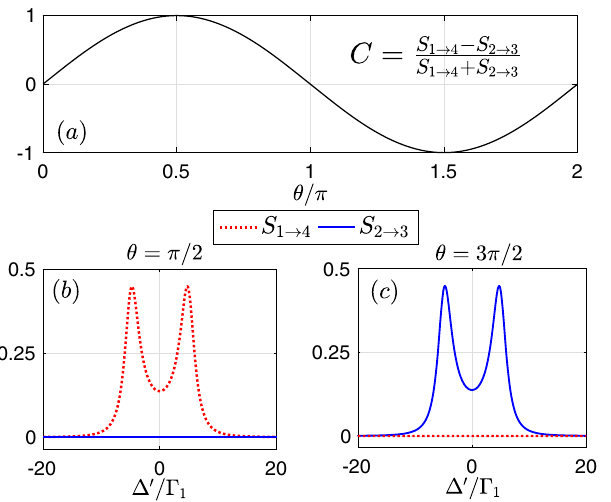
Fig. 7 Chiral scattering behaviors in a three-level ∇ -type giant-atom system. a Chirality C versus the coupling phase difference θ with the detuning Δ 0 ¼ 0. Scattering probabilities S 1 → 4 and S 2 → 3 versus Δ 0 for b θ = π /2 and c θ = 3 π /2. Other parameters: atomic dissipation rates γ ¼ γ ¼ 0, the ratio of two atomic emission rates into different e 1 e 2 waveguides Γ 2 / Γ 1 = 1, Rabi frequency of the external coherent fi eld Ω = 5 Γ